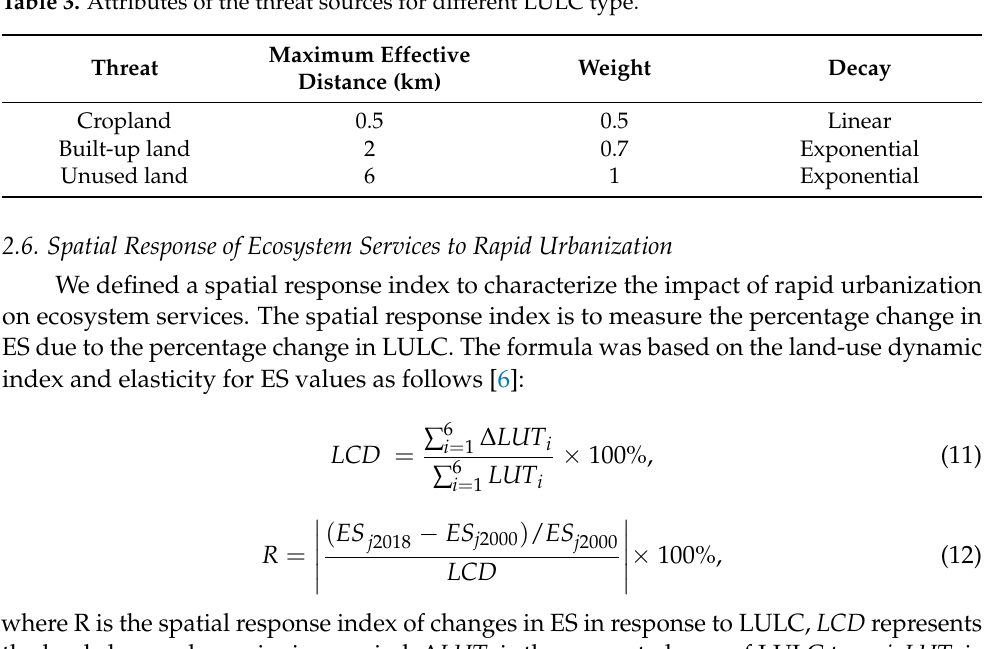
Table 3. Attributes of the threat sources for different LULC